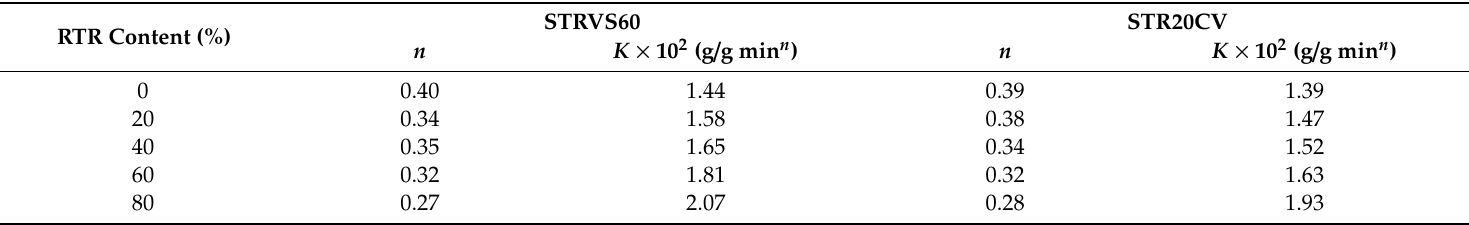
Table 7. Values of n and K (Equation (5)) for RTR / NR blends (compounding by a two-roll mill at 25 ◦ C) (reproduced with permission from